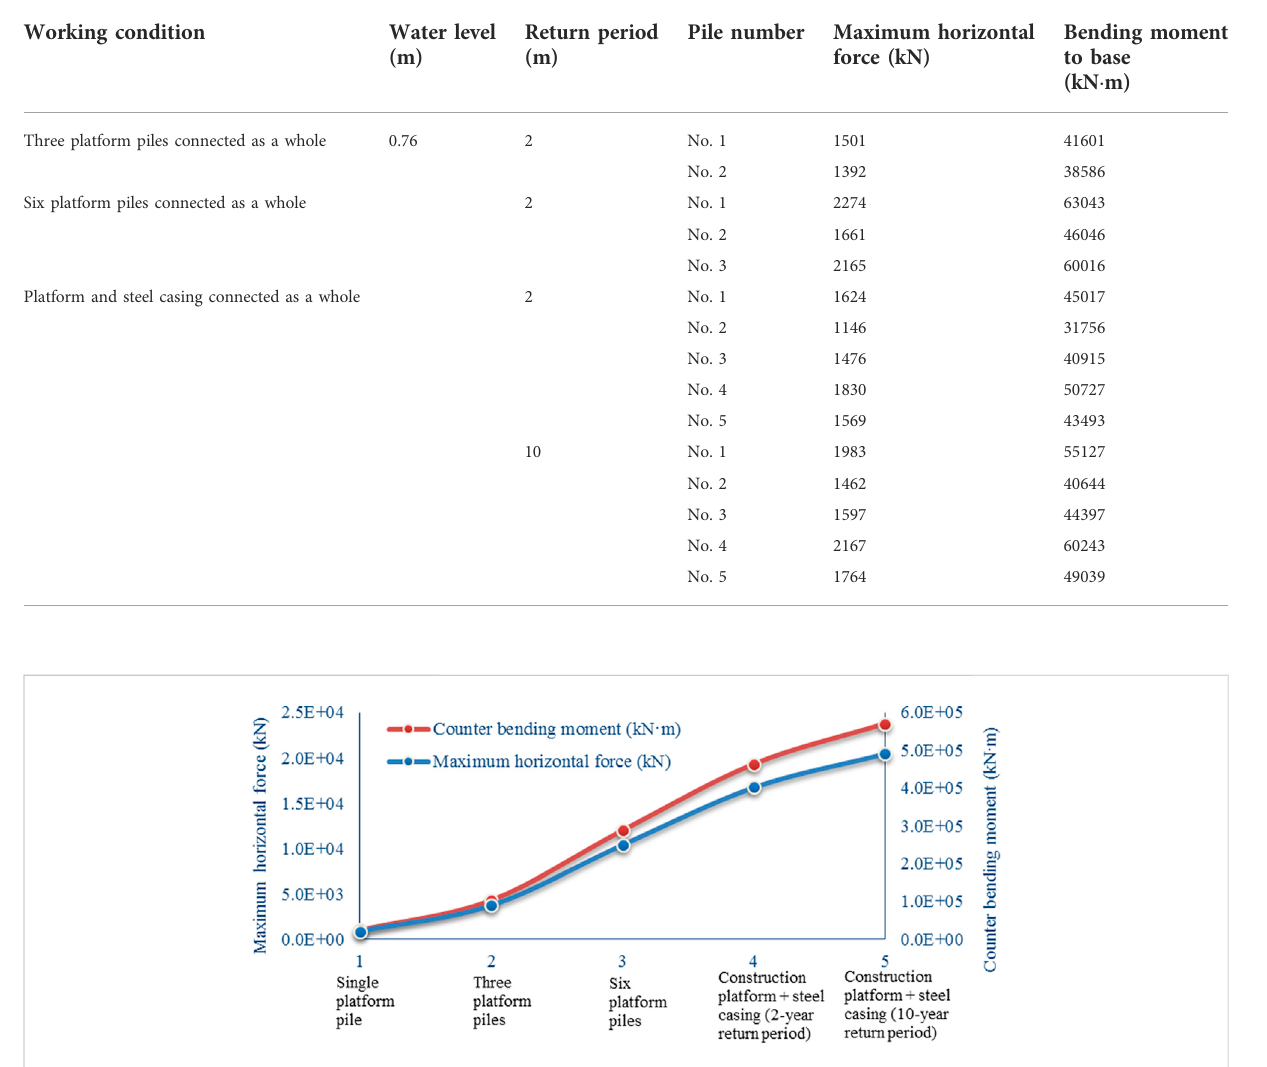
TABLE 5 Test results of wave and current forces on typical piles.